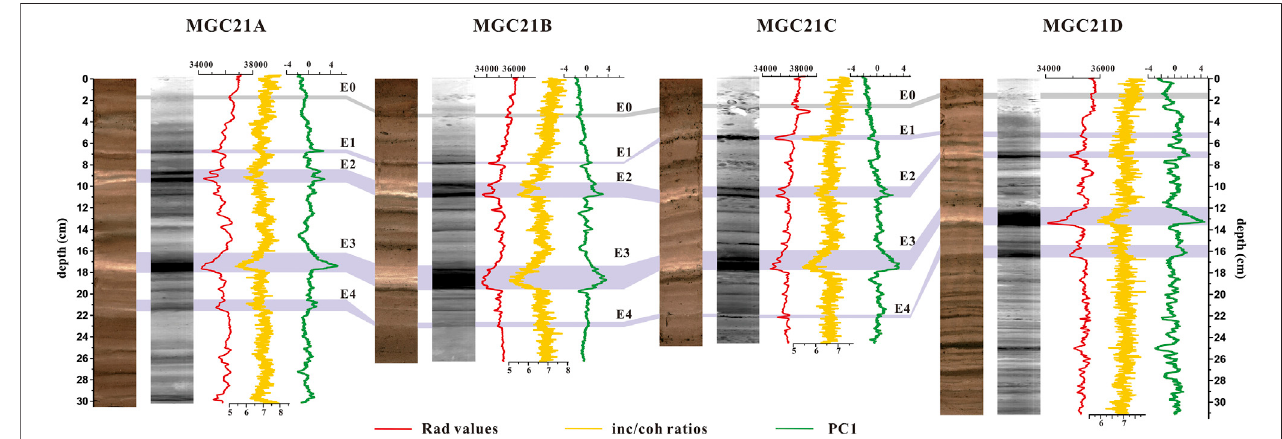
FIGURE 5 | Comparison of E0-E4 event layers characterized by Rad values, inc/coh ratios, and PC1 among the different cores in Lake Mugeco.